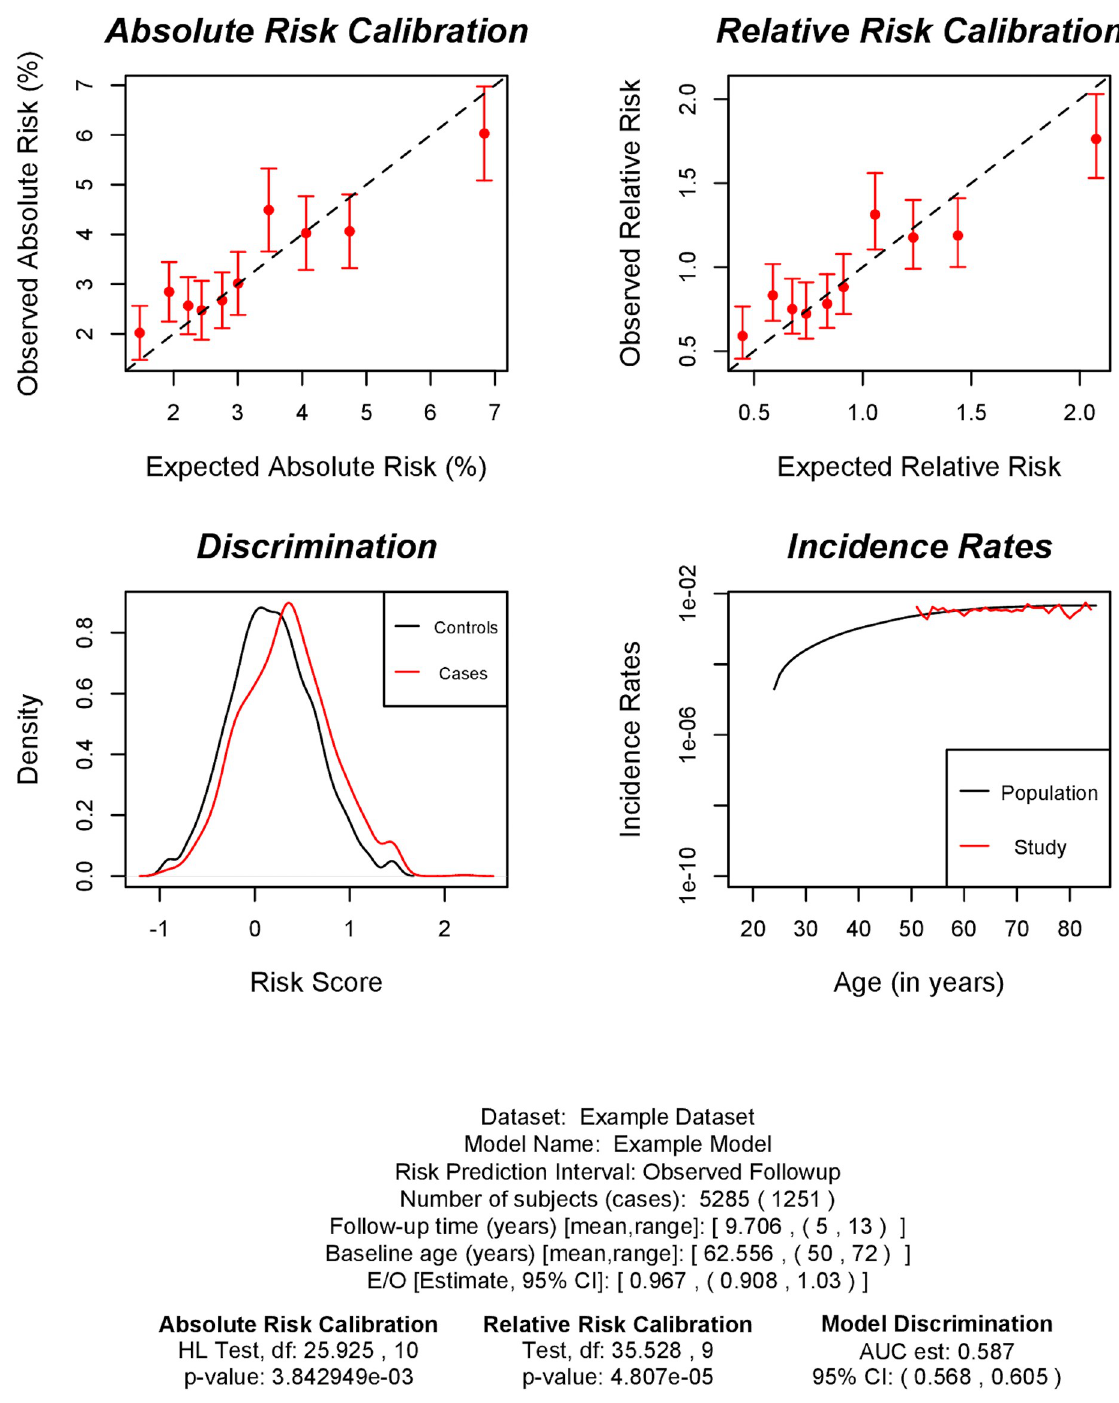
Fig 2. Plots showing model validation results. The top left panel shows calibration results for absolute risk; the top right panel shows calibration for relative risk with respect to the average risk in the validation study; the bottom left panel shows the distribution of risk score in cases (red) and controls (black); the bottom right panel shows the population incidence rates (black) and the incidence rates estimated in validation study (red).